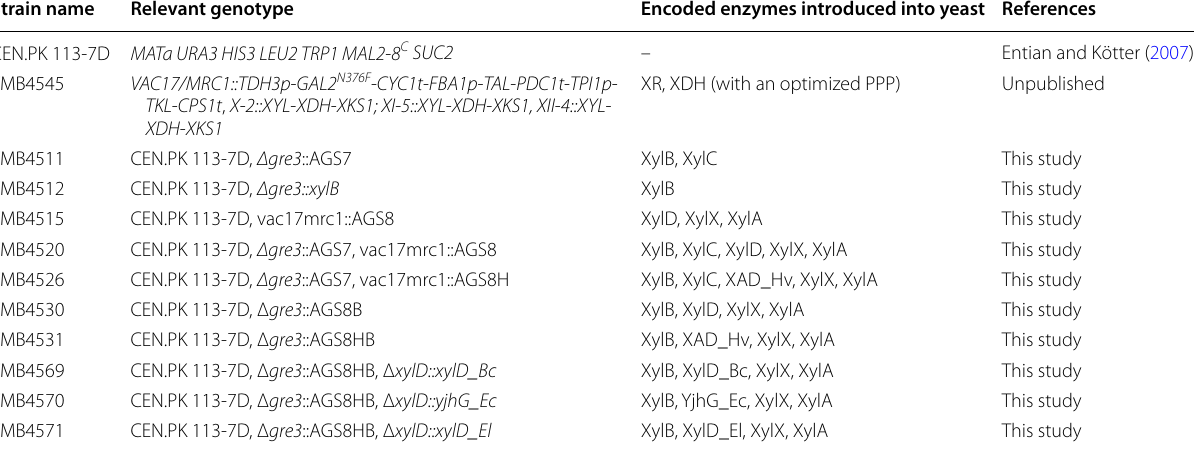
XR: d -xylose reductase, XDH: xylitol dehydrogenase, PPP: pentose phosphate pathway, XylB: d -xylose dehydrogenase, XylC: Xylonolactonas, XylD: d -xylonate dehydratase, XylX: 2-keto-3-deoxy- d -xylonate dehydratase, XylA: α-ketoglutarate semialdehyde dehydrogenase, Hv: Haloferax volcanii , Bc: Burkholderia cenocepacia